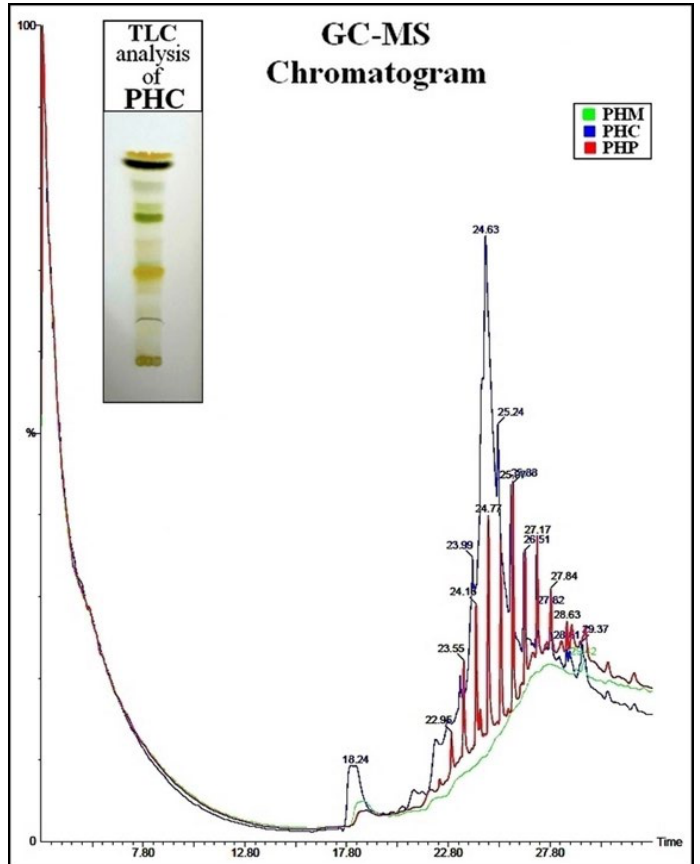
Fig. 3. Gas Chromatogram of all three extracts of Parthenium hysterophorus ; TLC of chloroform extract of Parthenium